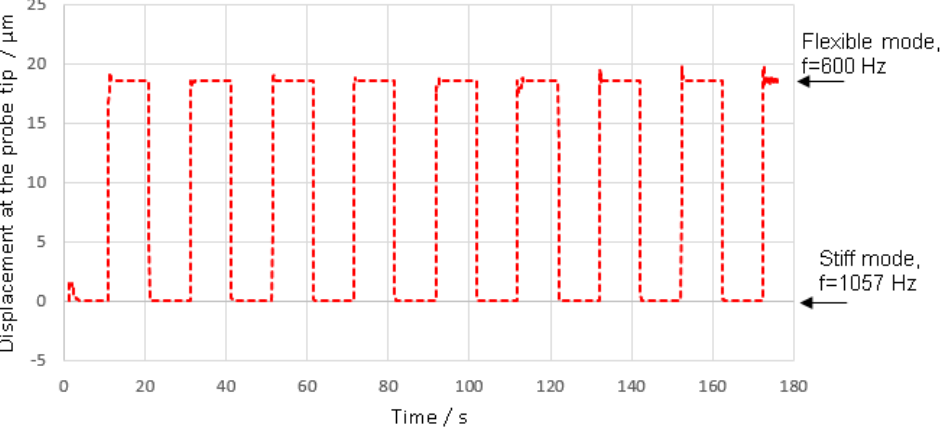
Figure 17. Plot showing control of the position of the probe tip in three dimensions between stiff and flexible mode using resonant frequency (the frequency of the stiff and flexible mode are 1057 Hz and 600 Hz, respectively).